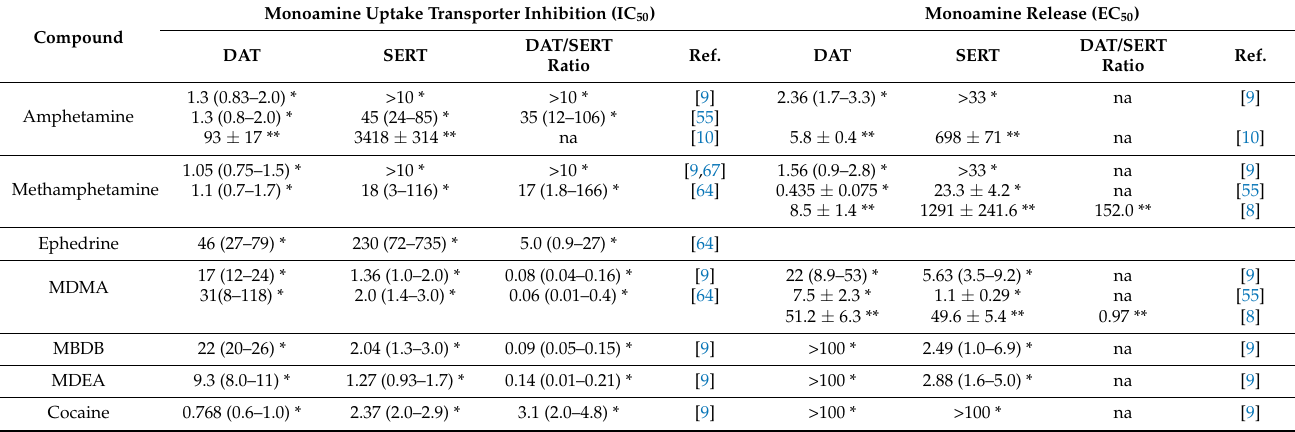
Table 2. In vitro dopamine and serotonin uptake transporter inhibition (IC 50 values) and release data (EC 50 values). Monoamine Uptake Transporter Inhibition (IC 50 Compound